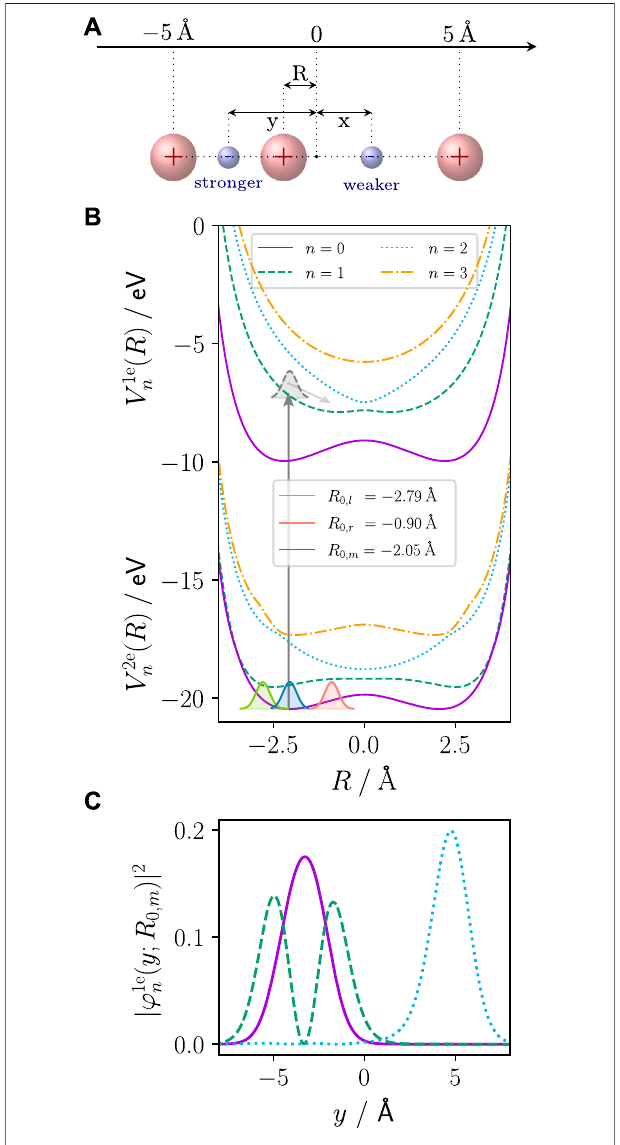
FIGURE 1 | (A) Extended Shin – Metiu model system: two electrons ( x , y ) and one nucleus I move in one dimension in the fi eld of the two outer fi xed (point charge) nuclei ( R ). For R < 0 as in the focus of investigation here, the left electron (here: y ) is stronger bound, while the right electron (here: x ) is weaker bound. The electrons are indistinguishable and are just given de fi ned labelshere forvisualisation purposes. (B) PECs ofthe2esystem, V 2e n ( R ) ,and the 1e parent ion, V 1e n ( R ) . The vertical line indicates one-photon ionisation and the population of the parent ion states. As an example, the nuclear wave packetinthe n =1ionstateisshowntogetherwiththegradientexertedbythe PEC on it (grey shaded Gaussian). In the 2e system ground state ( n = 0), the threedifferentinitialnuclearwavepacketsinvestigatedinthisworkareshown. The nuclear wave packet near the equilibrium position of R 0, m = − 2.05 Å (blue shadedGaussian),andthetwonon-equilibriumstartingwavepacketsstarting at the isopotential turning points left, R 0, l = − 2.79 Å (green shaded Gaussian), and right, R 0, r = − 0.90 Å (red shaded Gaussian), of the equilibrium. (C) The absolutesquareofthe fi rstthree1eparentionwavefunctionsshowsthat n =2 (blue dotted) is located at y > 0 (weaker bound).